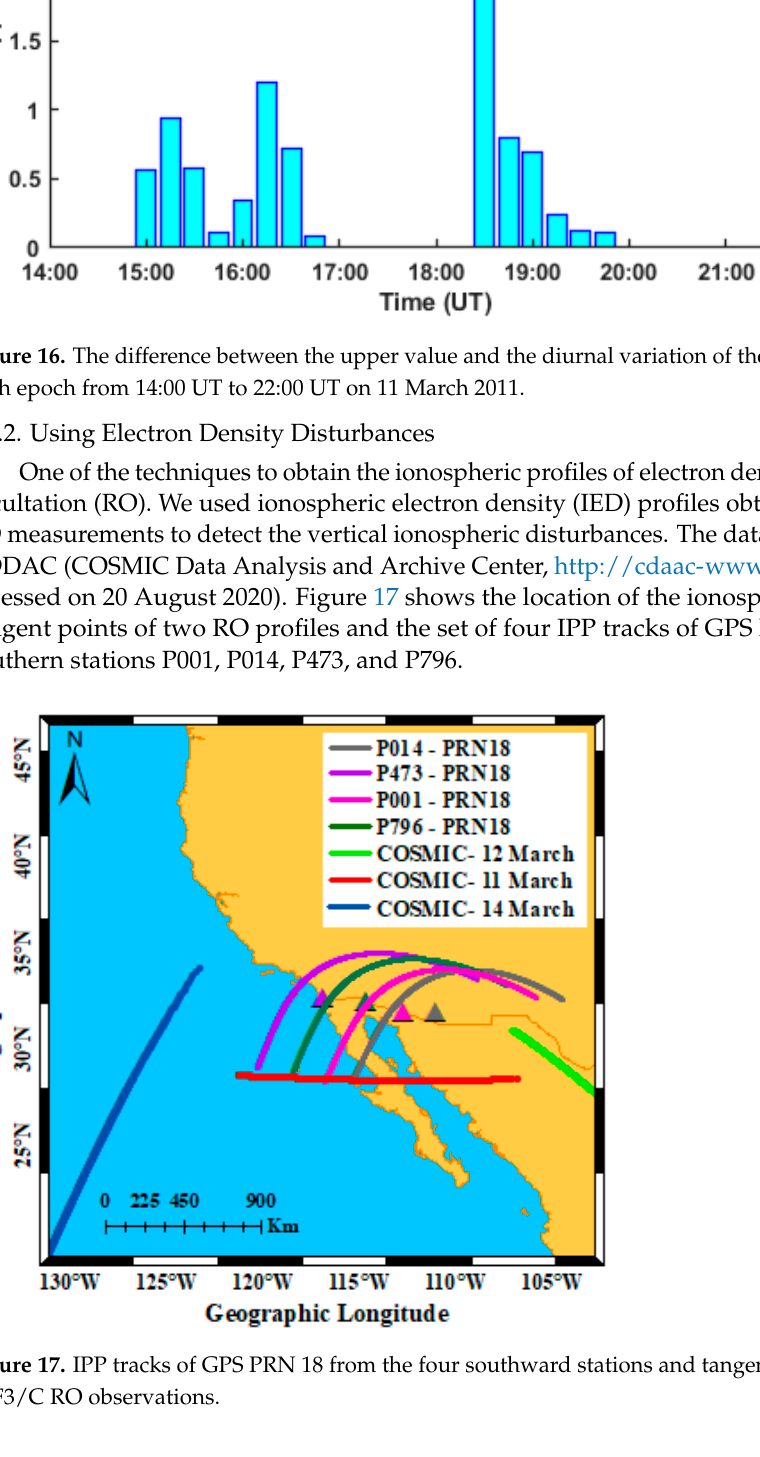
Figure 15. Variations in the ionospheric parameter foF 2 obtained at PA836 from 10 to 12 March 2011 (red line), for (a) 10 th , (b) 11 th , and (c) 12 th March 2011. The solid blue line is lower values of foF 2 parameter on quiet days (10 and 12 March 2011). The solid green line is upper values of foF 2 param- eter on quiet days (10 and 12 March 2011). Blue dot line is the average of quiet day values (10 and 12 March 2011).